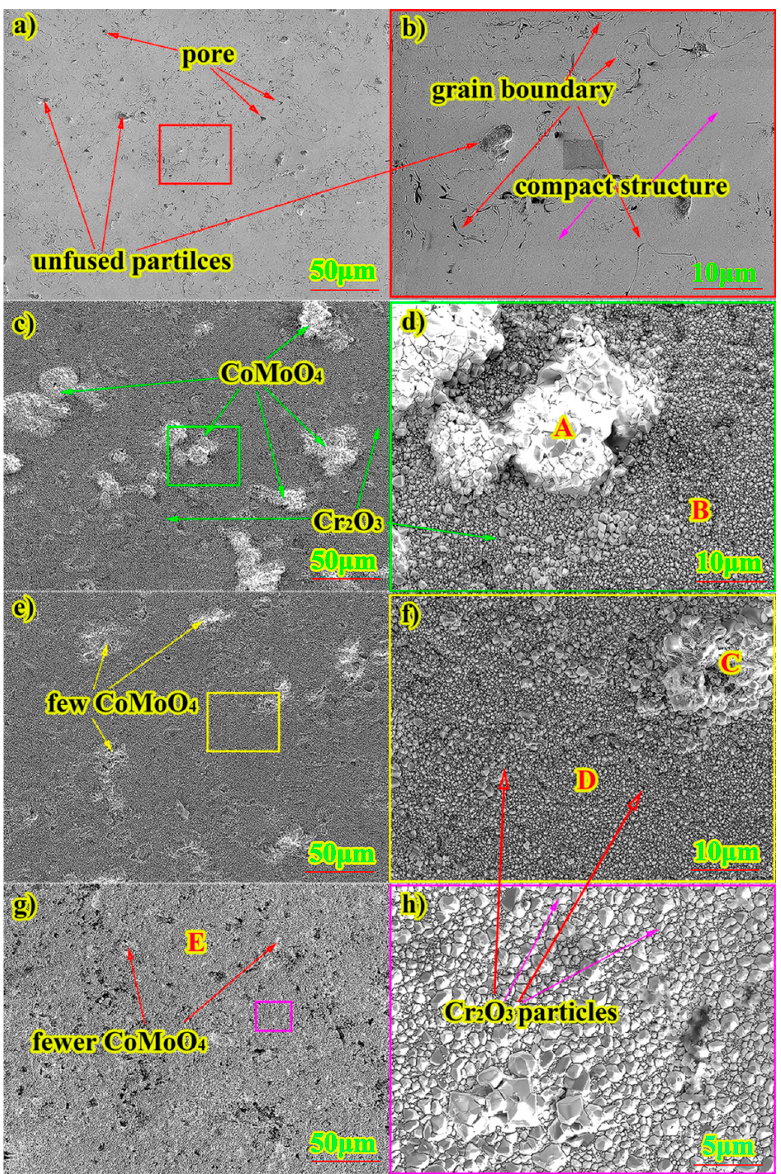
Figure 3. Surface SEM images of as-sprayed CoMoCrSi coating ( a , b ) and coatings annealed for 3 h ( c , d ), 5 h ( e , f ), and 10 h ( g , h ).